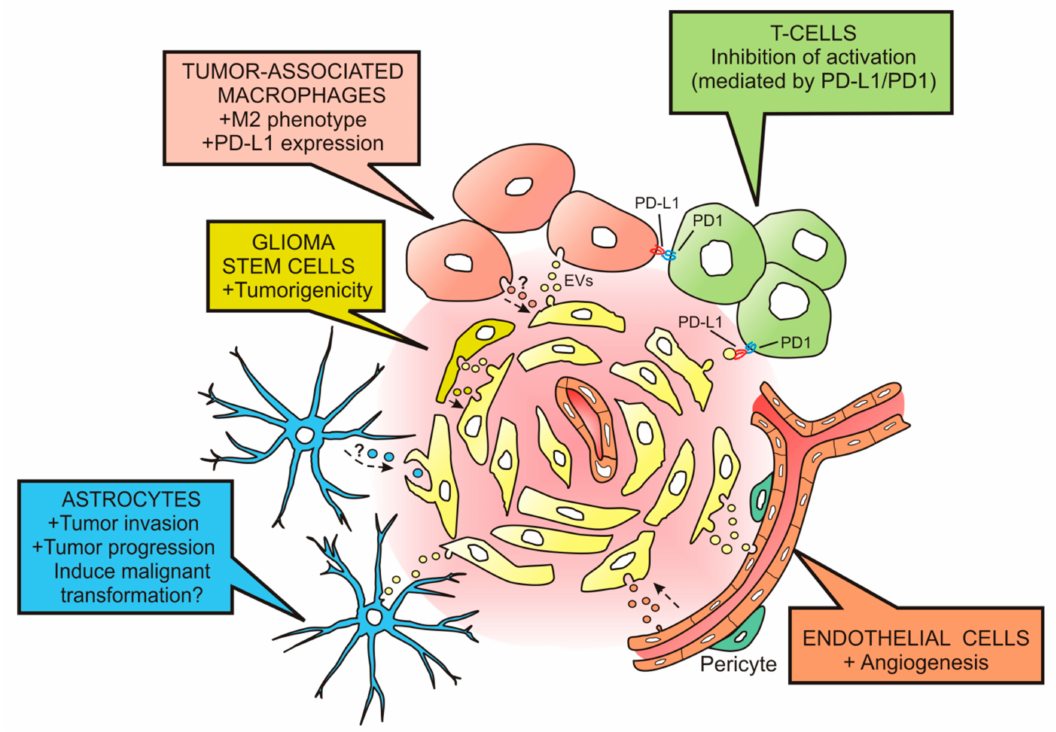
E ff ects of glioblastoma-derived extracellular vesicles on cells from the tumor microenvironment. Extracellular vesicles (EVs) released by glioblastoma (GBM) cells (in pale yellow) can be taken up by tumor-associated macrophages (in flesh color) to induce the M2 phenotype and the expression of PD-L1. By interacting with the ligand PD1 expressed on activated T cells (in green), they inhibit the T cell-associated immune response. Additionally, EVs can target T cells and suppress their activation through PD-L1 / PD1 interaction. Endothelial cells (in orange) are also targets for GBM-derived EVs; they activate angiogenic mechanisms. The uptake of GBM EVs by astrocytes (in blue) leads to astrocytic responses favoring tumor invasion and progression. The malignant transformation of astrocytes might also be produced by EVs delivering oncogenic cargo. GBM-derived EVs can also deliver their cargo in glioma stem cells (in dark yellow) producing an increase in their tumorigenicity. Tumor microenvironment components might also release EVs to induce e ff ects on the GBM cell population (see dashed